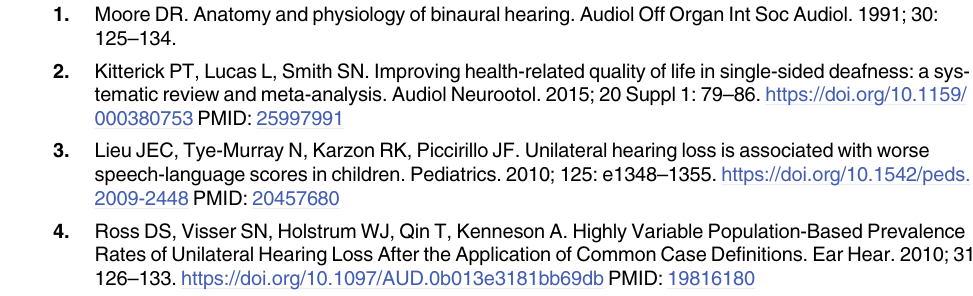
S3 Fig. Mean peak latencies for SSD-CI- L (left panels; Cz, T8, P8 and M2) and SSD-CI- R (right panels; Cz, T7, P7 and M1), and NH subjects (all panels); the error bars show the stan- dard deviation. S1 Table. Results of MANCOVAs for GFP, Cz, temporal (P7, P8; T7, T8) and mastoid sites (M1, M2). Sites were selected to be contralateral to the implanted ear. For Test session (Base, 6m, 12m), group (right- or left-implanted), CAEP components were fixed factors, amplitude (Amp) and latency (Lat) were the dependent variables), and subjects were the co-varying fac- tor. The asterisks and italics indicate significant effects. S2 Table. Results of Mann-Whitney tests comparing GFP and CAEP amplitude and latency at each test sessions between NH and SSD-CI subjects. Italics indicate significant effects after Bonferroni adjustment for multiple comparisons (p <